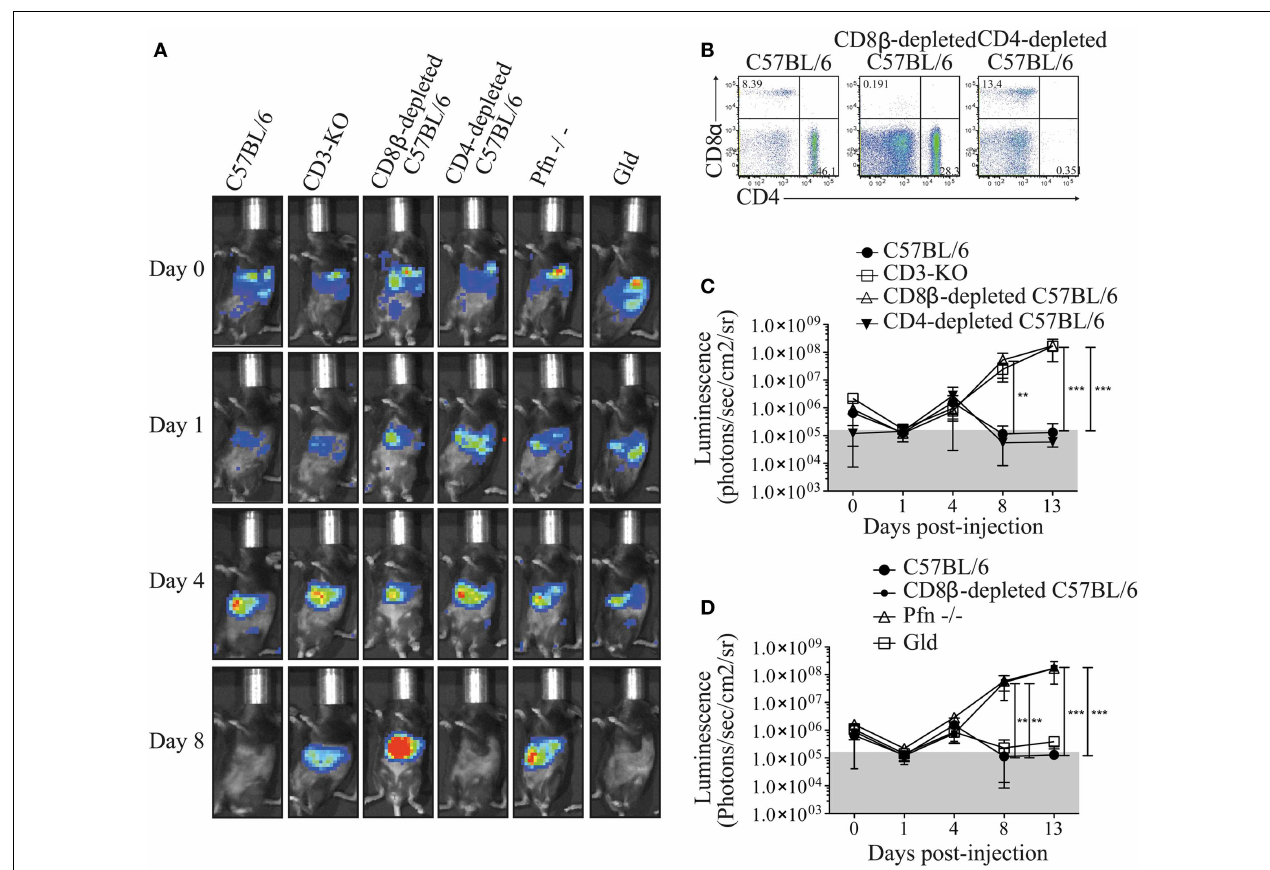
injection. (B) Two days before and 3days after Luc-DC injection, 100 µ g of CD8 β - or CD4-depleting antibody were administrated into C57BL/6 mice by ip injections.The effective depletion of CD8 + and CD4 + cells was checked by flow cytometry in the blood 1day after the last injection (gated on single live cells). (C,D) The bioluminescence measured in the various mouse strains was quantified as photons/s/cm 2 /sr. Data are presented as mean ± SD.The p values were determined by a two-way ANOVA with Bonferroni